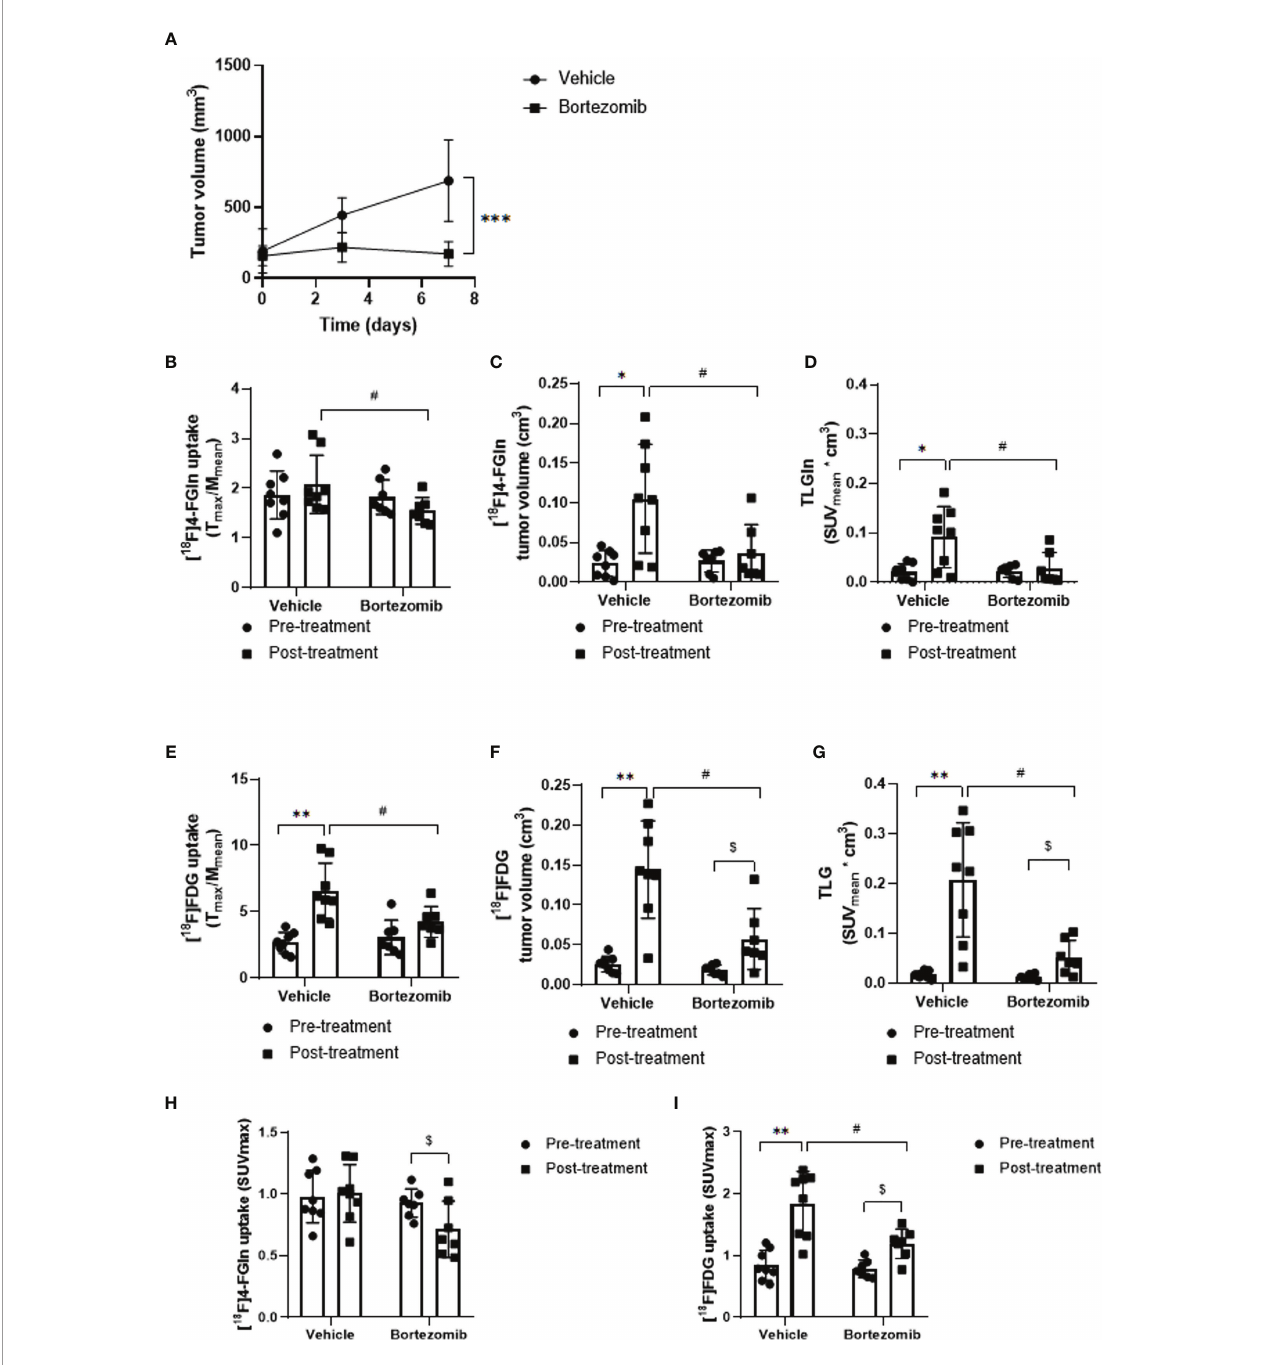
FIGURE 5 | Effect of Bortezomib treatment on [ 18 F]FDG and [ 18 F]4-FGln uptake measured by PET. (A) Tumor volume measured by caliper in vehicle and Bortezomib-treated mice. Data are expressed as mean ± SD and were analyzed by Unpaired Mann-Whitney test. ***p = 0.0006. (B, E) Quantitative analysis of [ 18 F] FDG and [ 18 F]4-FGln T/M uptake ratio before and after treatment with vehicle and Bortezomib. (C, F) Volumetric analysis of [ 18 F]FDG and [ 18 F]4-FGln uptake within the tumor region, pre- and post-therapy. (D, G) Quanti fi cation of total lesion glycolysis (TLG) and total lesion glutamine (TLGln) within the tumor region, pre- and post-therapy. Differences intra- and intergroups were tested for signi fi cance using Wilcoxon matched-pairs signed rank-test and Unpaired Mann-Whitney test. *, #, $, p < 0.05; **p < 0.01. (H) Quantitative analysis of [ 18 F]4-FGln and (I) [ 18 F]FDG SUVmax uptake before and after treatment with vehicle and Bortezomib. Differences intra- and intergroups were tested for signi fi cance using Wilcoxon matched-pairs signed rank-test and Unpaired Mann-Whitney test. #, $, p < 0.05; **p <